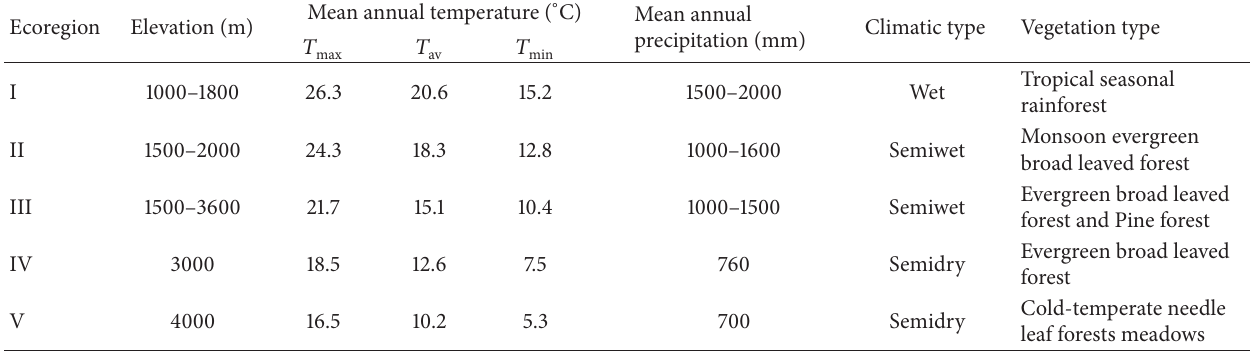
Table 1: Climate, vegetation, and topography by ecoregion in Yunnan province.